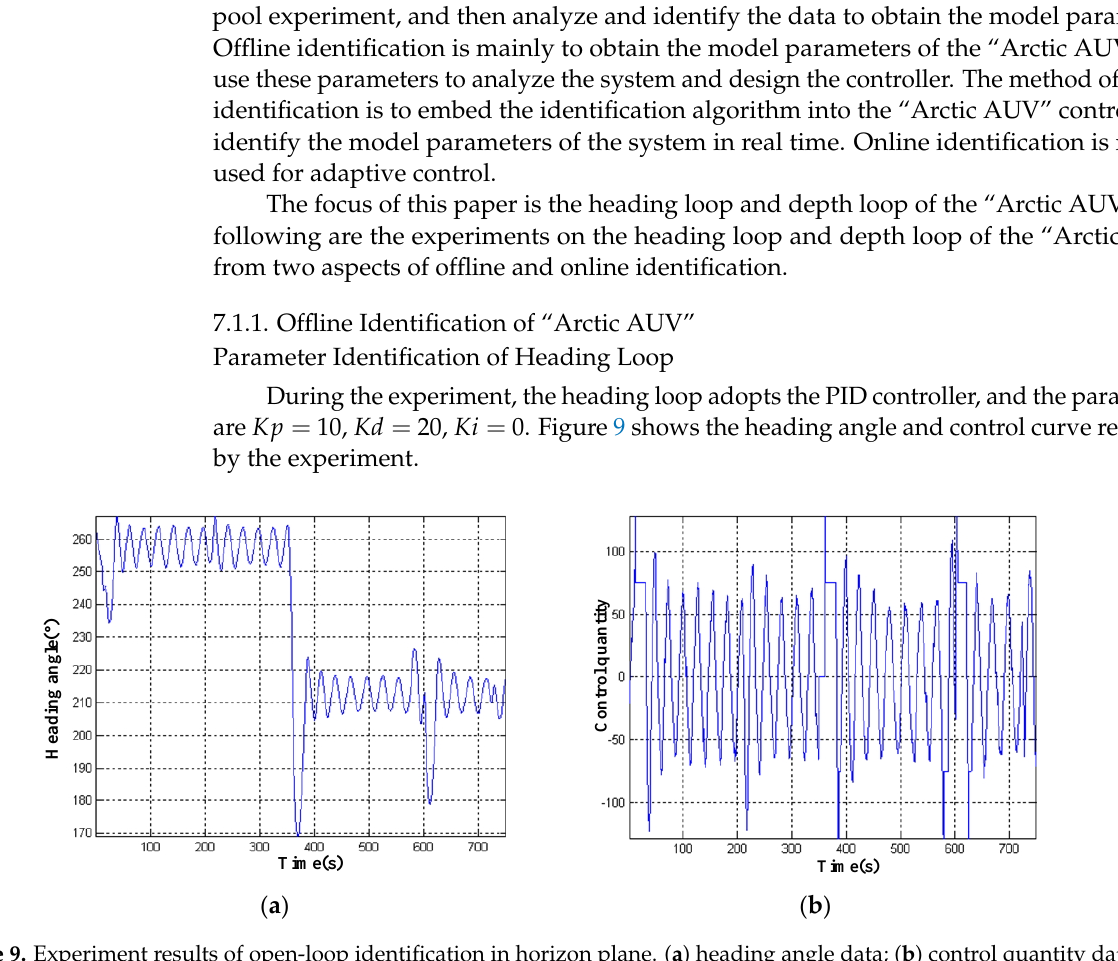
Table 2. Identification errors of V(n) for heading loop with different delay time parameter d. Delay Time